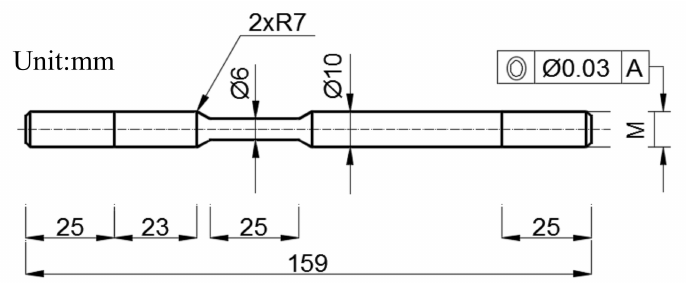
Figure 1. Diagrammatic sketch of the slow strain rate tensile (SSRT) test sample with its